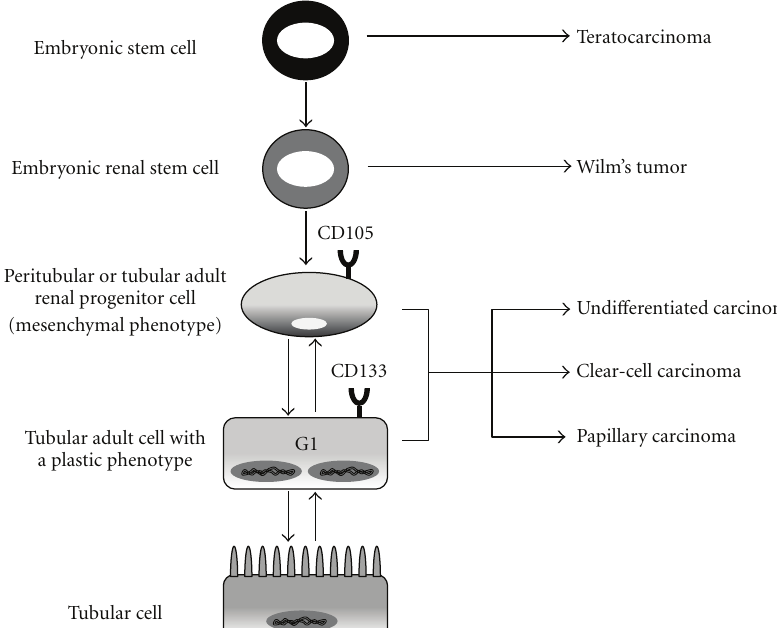
Figure 1: Scheme representative of the possible stem cell origin of renal CSCs. Mutations/epigenetic alterations of the renal embryonic stem cells may originate the pediatric malignancy Wilm’s tumor. The di ff erent histologic types of renal carcinomas of the adult may derive from mutations occurring in the stem cell compartment of the adult kidney. The lack of CD133 + marker in renal CSCs may support the idea of an origin from a yet unidentified mesenchymal population, which is ahead of CD133 + renal progenitors in the di ff erentiation linage. Alternatively, a process of de-di ff erentiation of renal progenitors or mature cells could be